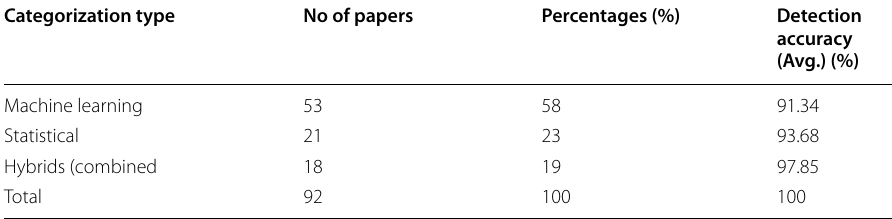
Table 1 Categorization of implemented